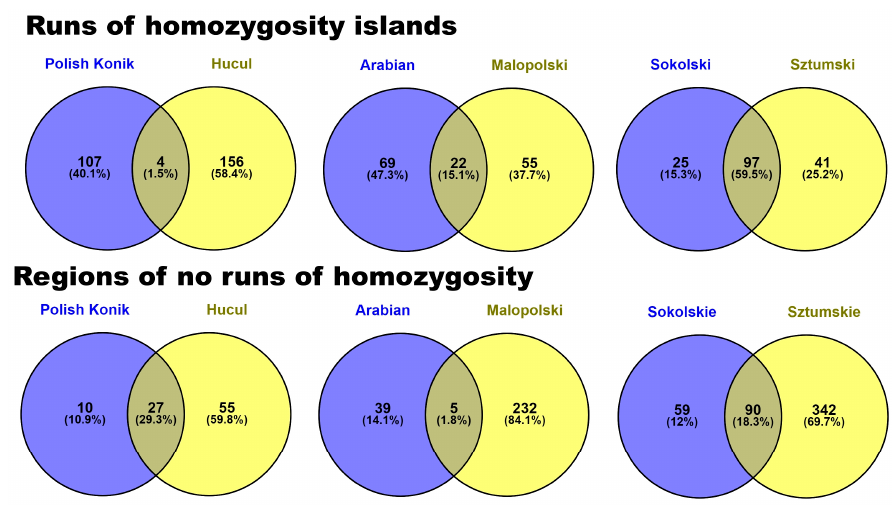
Figure 6. Common genes identified in ROH islands and no-ROH regions between horse breeds in regard to horse type. Lastly, a comparison of EcuCab3 recombination map and ROH patterns for Arabian breed was proposed, which showed a visible relationship between ROH islands and re- combination rate. This phenomena was especially evident in the case of chromosome 11 which is presented in Figure 7. All other chromosomes for which ROH islands and no- ROH regions were identified are presented in Supplementary Figure S9.